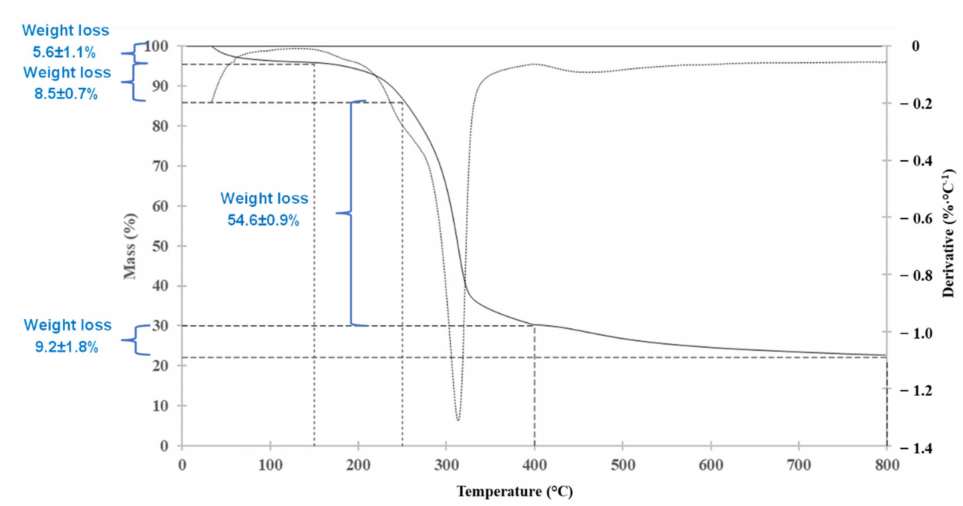
Figure 1. Thermogravimetric degradation of hemp from 0 to 800 ◦ C under N 2